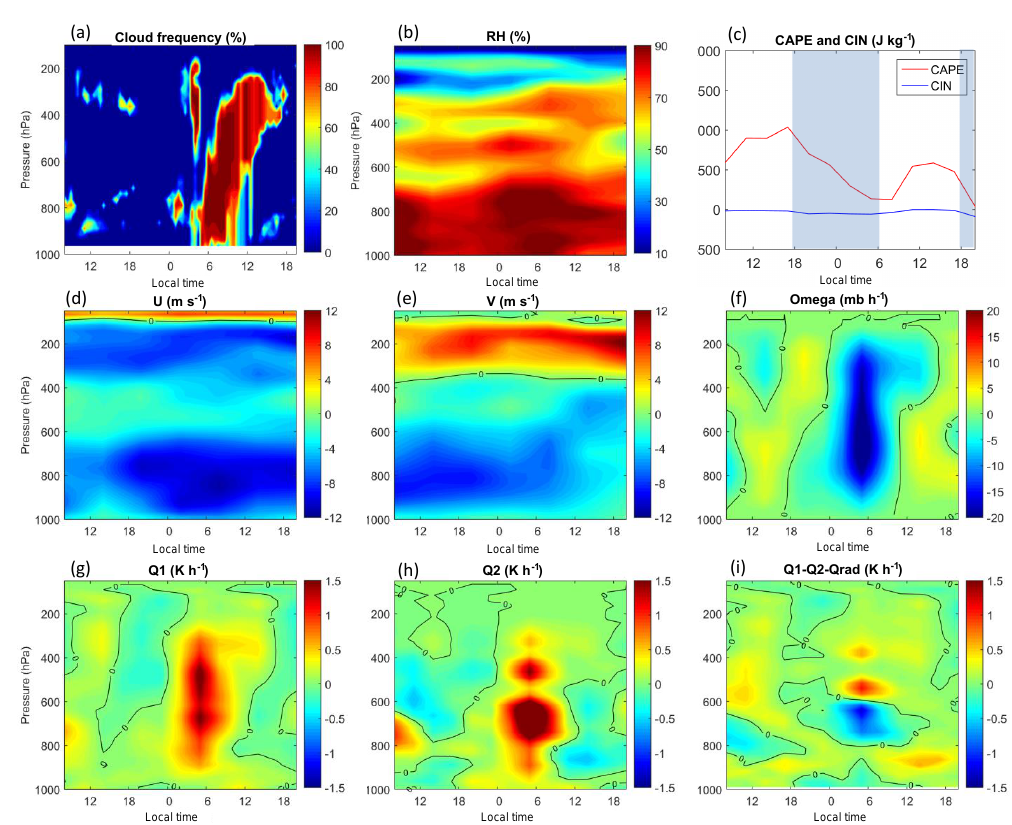
Figure 11. Similar as Fig. 10 but for the COS